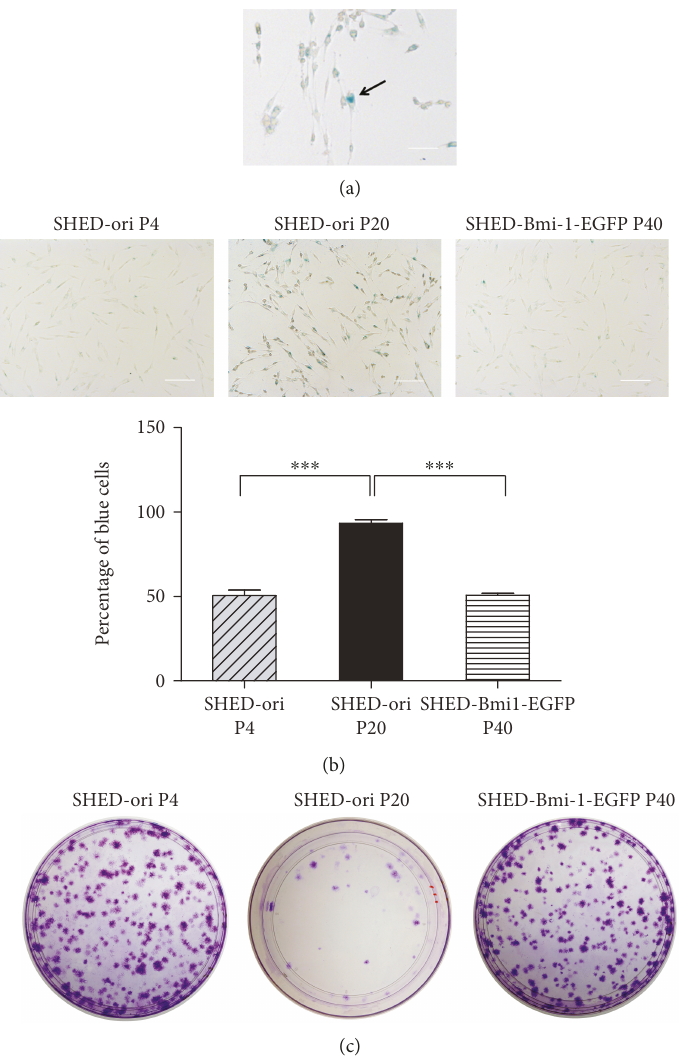
Figure 2: Senescence level and proliferation capacity of SHED-ori and SHED-Bmi1-EGFP. (a) Blue cells were counted as a measure of senescence. Scale bar, 100 μ m. (b) SHED-ori were stained with β -gal at P4 and P20. SHED-Bmi1-EGFP were stained at P40. Blue cells were counted as a measure of senescence. Scale bar, 200 μ m. (c) Colony formation assay was performed to measure the proliferation capacity of SHED-ori P4, SHED-ori P20, and SHED-Bmi1-GFP